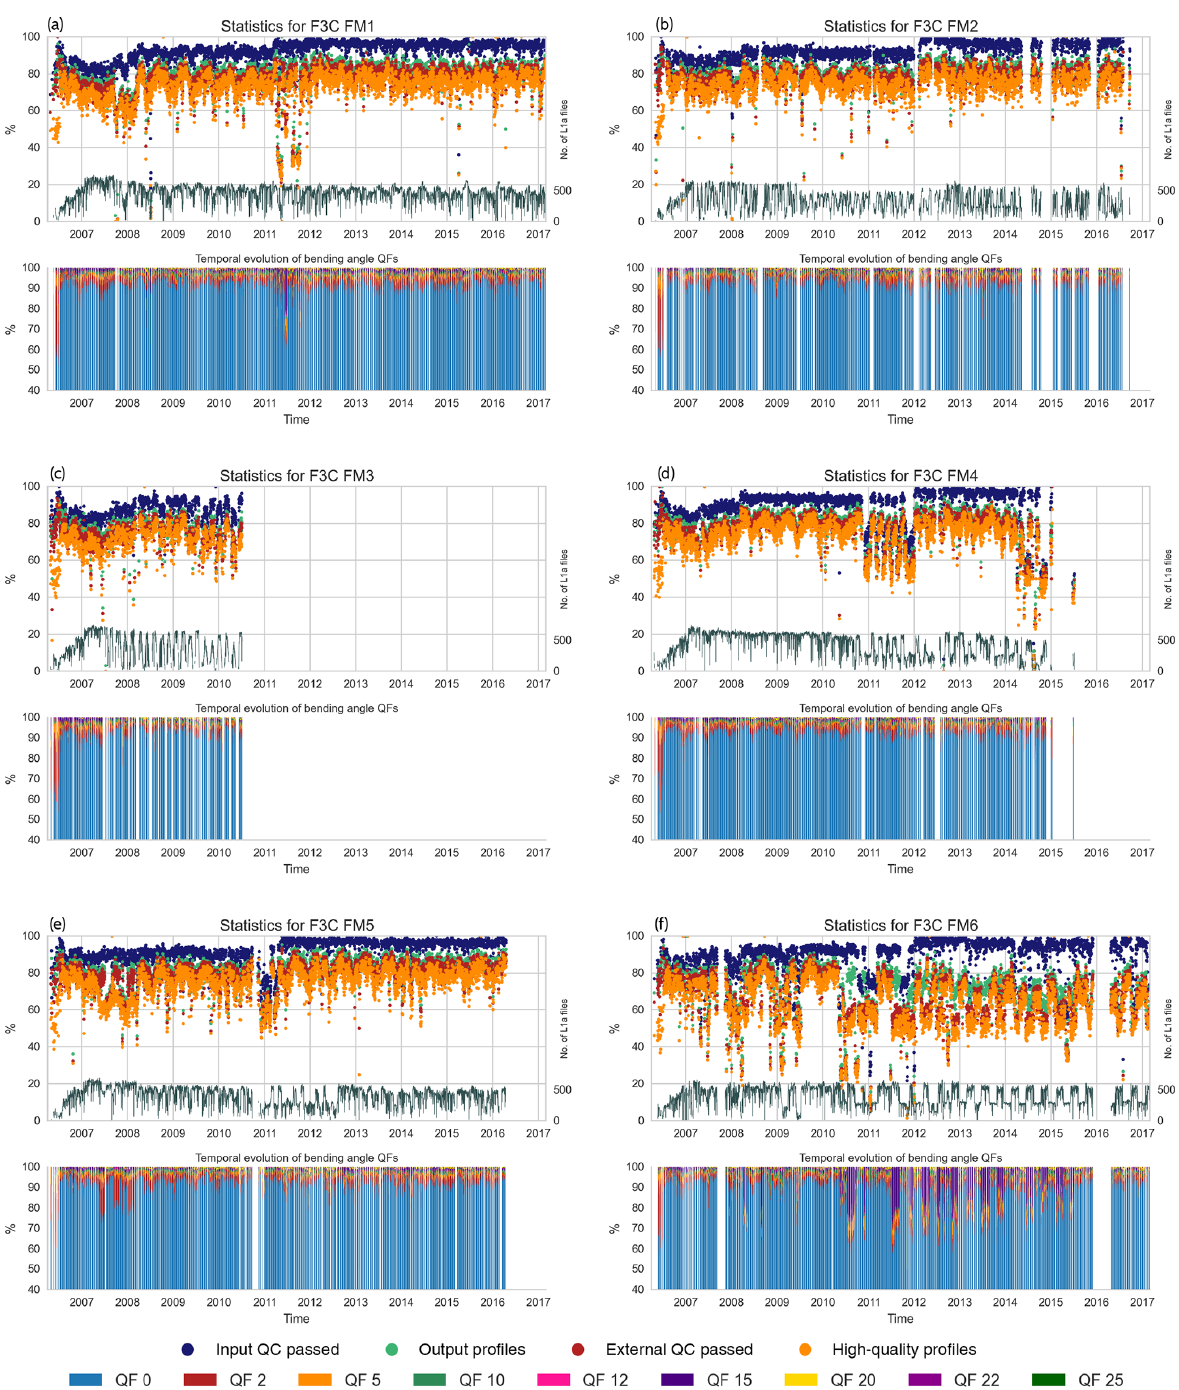
Figure 3. Temporal evolution of daily percentage of profiles (relative to total number of input data) passing the various QC steps for the six F3C satellites, (a) FM1, (b) FM2, (c) FM3, (d) FM4, (e) FM5, and (f) FM6. Upper subpanels of (a) – (f) show the number of profiles passing the input QC (blue dots); the number of bending angle profiles passing internal QC, which equals the number of output profiles (green dots); the number of profiles that are within the defined limits in the external QC (bending angle QF is 0, 2, or 5, and all atmospheric QF are 0) (red dots); and the daily percentage of high-quality OPSv5.6 profiles (orange dots). Daily percentage of flagged profiles relative to the number of OPSv5.6 output profiles is shown separately for each bending angle QF in the lower